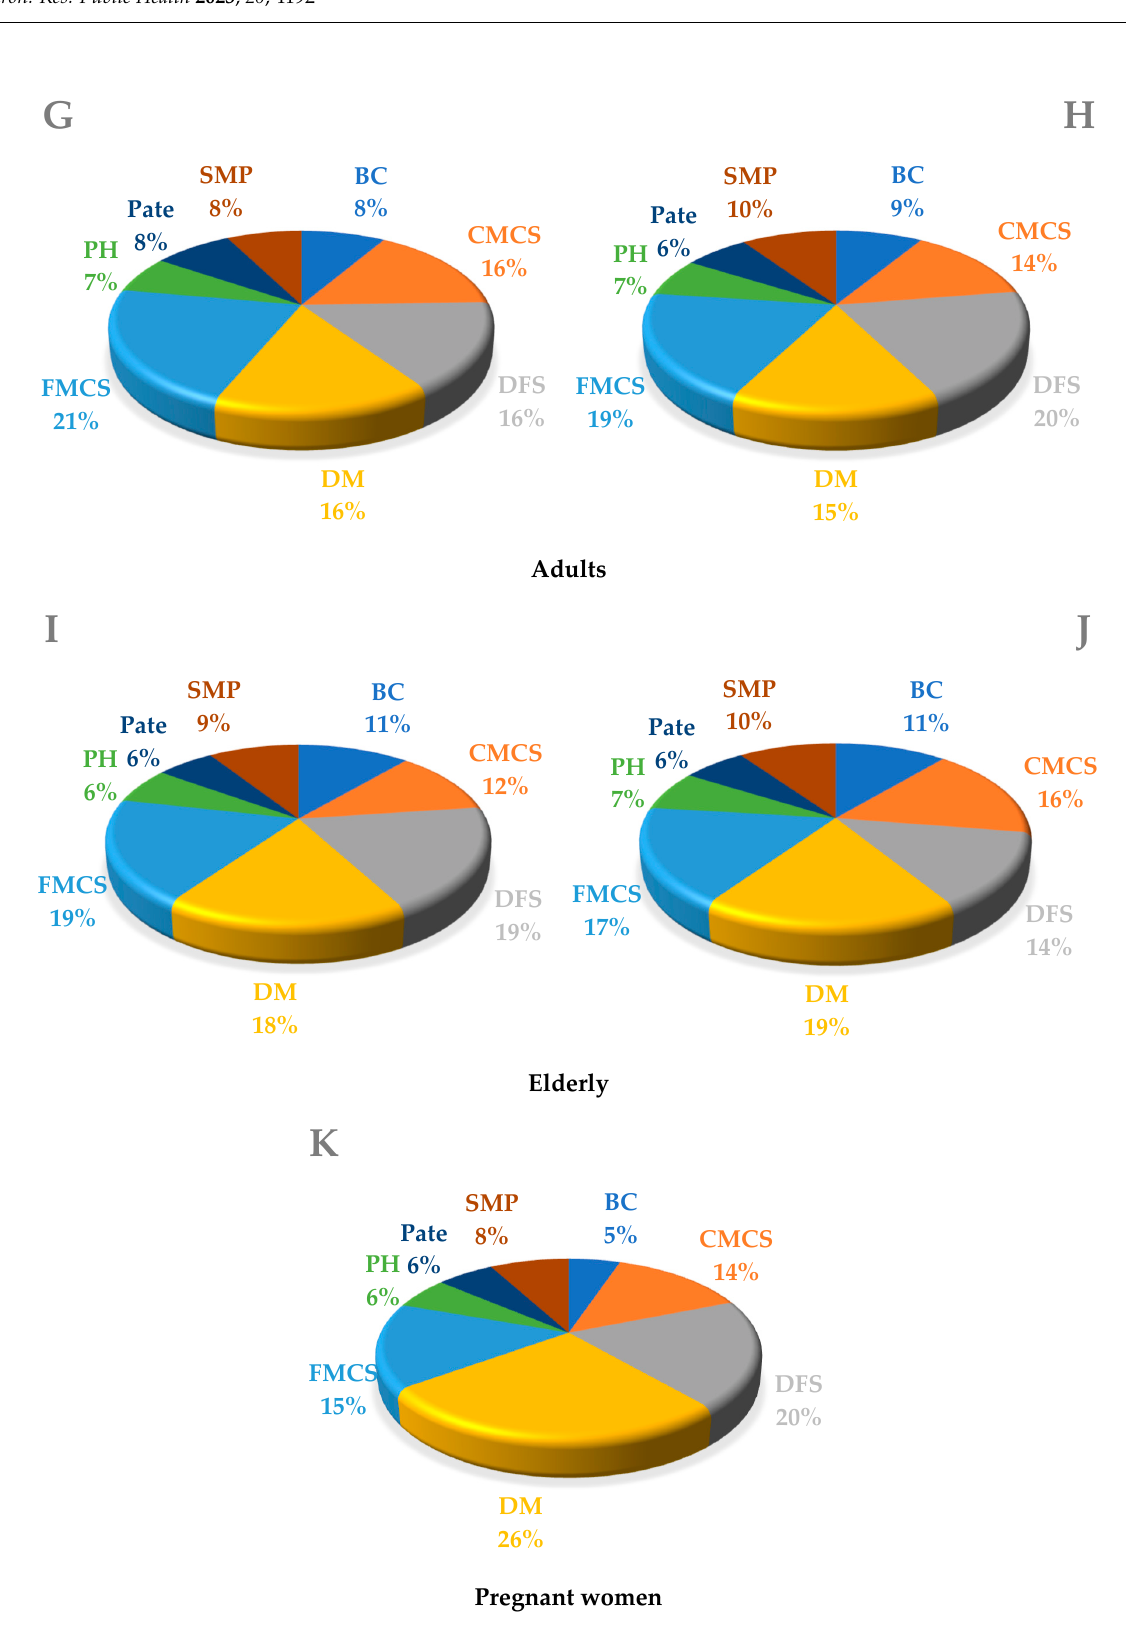
Figure 2. Contribution (%) of the most important groups of meat products to dietary exposure to salt. Legend: CMCS—coarsely minced cooked sausages; DFS—dry fermented sausages; DM—dry meat; FMCS—finely minced cooked sausages; PH—pasteurized ham; SMP—smoked meat products; ( A , C , E , G , I ) male; ( B , D , F , H , J) female; ( K ) pregnant women.